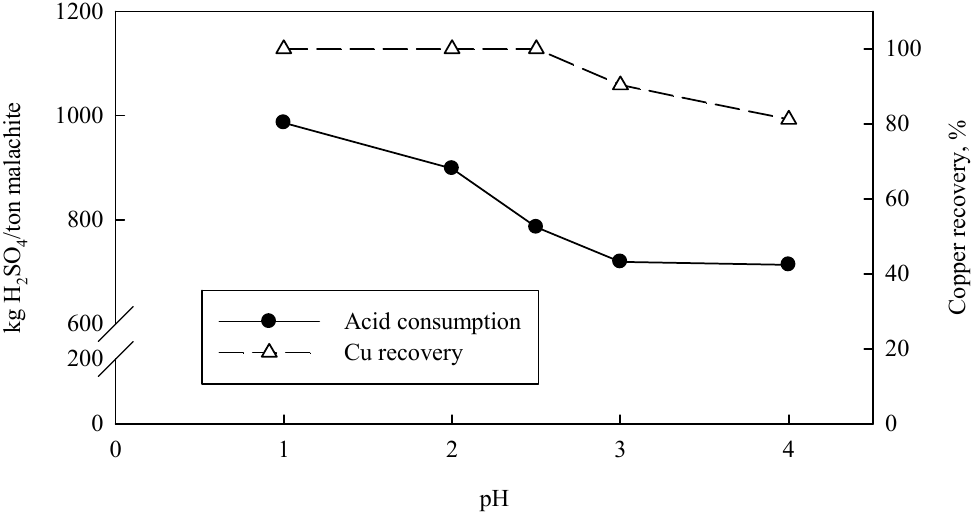
Figure 2. Sulfuric acid consumption (kg H 2 SO 4 / ton malachite) and copper recovery (%) depending on the pH of the solution.